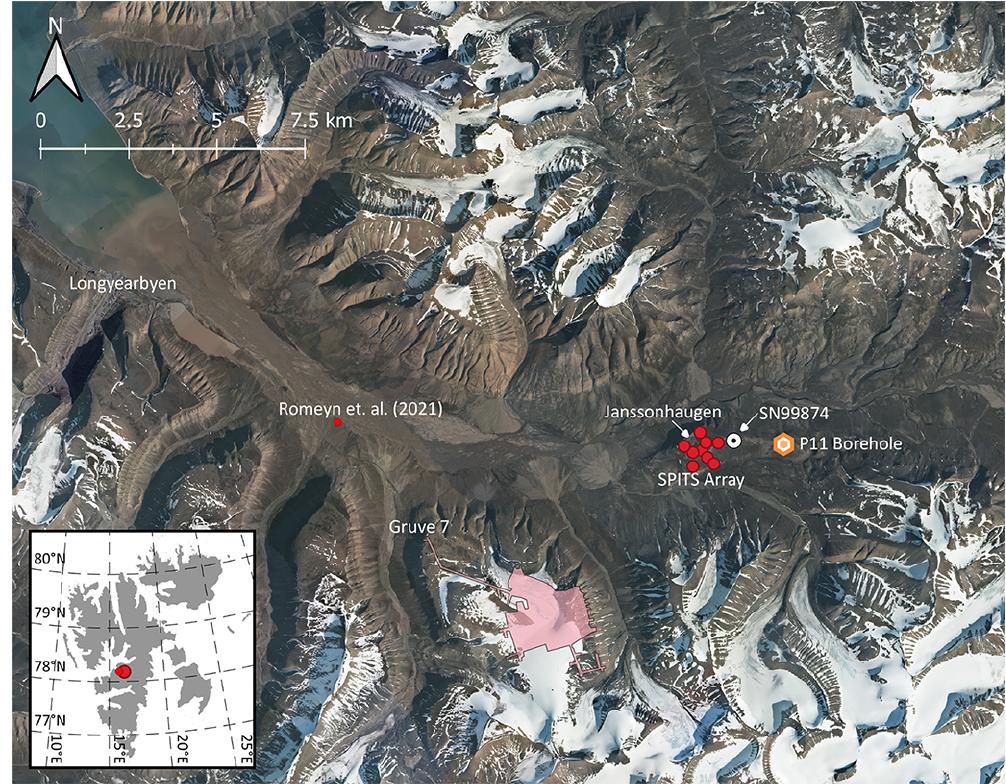
Figure 2. Overview of the location of the SPITS array located on Janssonhaugen in Adventdalen, Svalbard, up-valley from the settlement of Longyearbyen and the temporary seismic array of Romeyn et al. (2021). The P11 temperature logging borehole and the underground mining areas and tunnels of the operational coal mine, Gruve 7, are also shown. The http://met.no (14 January 2022) weather station “Janssonhaugen Vest” is marked by its station number, SN99874. Orthophoto © Norwegian Polar Institute (http://npolar.no, 17 January